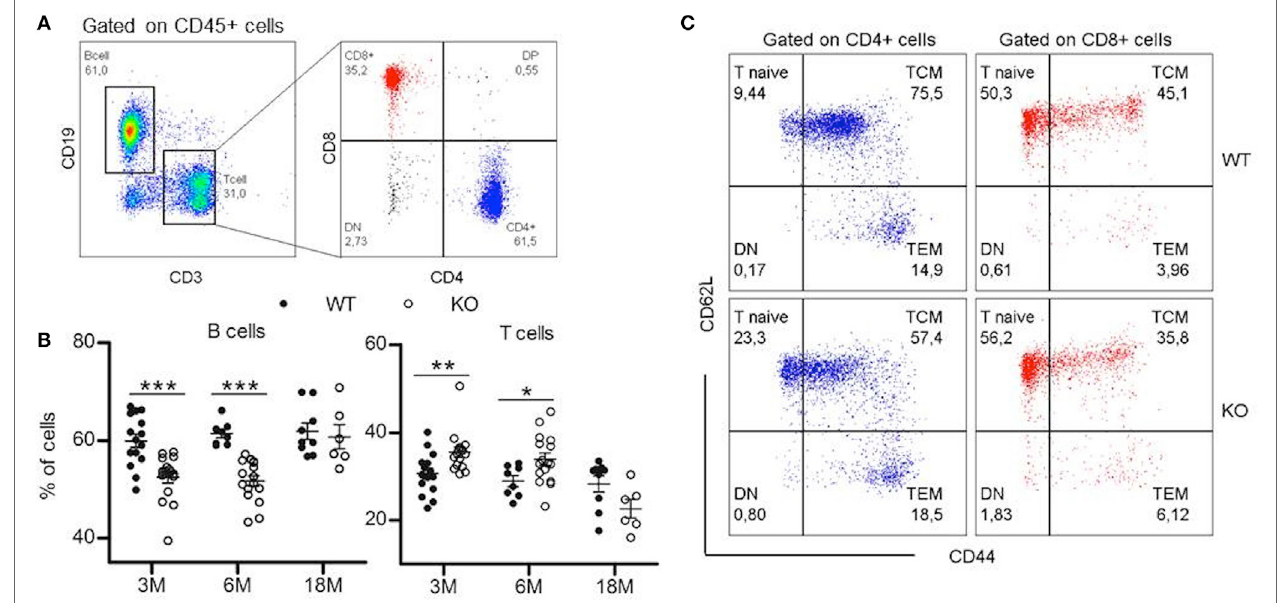
FigUre 2 | Lymphocytes distribution in periphery. (a) Representative flow cytometry plots showing immunophenotyping of peripheral lymphoid compartments (blood, spleen, and lymph nodes). CD19 + B cells and CD3 + T cells are analyzed within the CD45 + population. T cell population is divided into CD4 + and CD8 + T cells. 20,000 CD45 + events are recorded. (B) Proportions of B and T cells in the spleen of KO (white circles, n = 6–16) compared with wild-type (WT) (black circles, n = 8–15) mice at 3, 6, and 18 months. Data (mean ± SEM) are representative of two to three independent experiments except for the KO18M group analyzed in a single experiment. Unpaired t -test was used for statistical analysis. *** p < 0.001, * p < 0.05. (c) Representative flow cytometry plots for phenotyping of naïve and memory T cells in the spleen of 3-month-old WT and KO mice. Naïve (CD44 low CD62L hi ), TCM (CD44 hi CD62L hi ), and TEM (CD44 hi CD62 low ) cells are analyzed within the CD3 + CD4 + (blue) or CD3 + CD8 + (red)